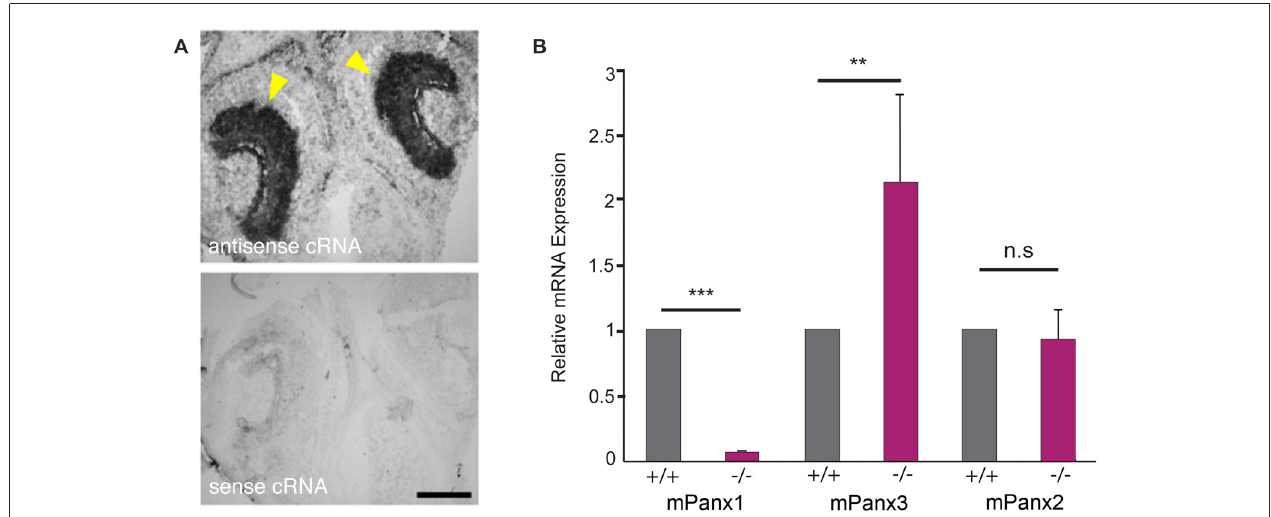
FIGURE 1 | Pannexin mRNA expression in the mouse VNO. (A) In situ hybridizations (ISHs) from juvenile mice (P7) with mPanx1 riboprobes. Panx1 antisense cRNA delivered strong labeling in the VNO. The strongest staining was detectable in the basal cell layer of the sensory epithelium (SE) indicated by yellow arrowheads. Note the absence of specific staining when the Panx1 sense cRNA was used. VNO = vomeronasal organ. Scale bar = 100 µ m. (B) Quantitative room temperature (RT)-PCR data for Panx expression in the VNO. Panx1 − / − mice lacked detectable mPanx1 expression in the VNO ( n = 6). Mouse Panx3 mRNA expression showed a significant 2-fold upregulation in the VNO of Panx1 − / − mice. No differential mRNA regulation was found for mPanx2. Primers specific for 18S rRNA were used as a reference. Experiments were performed in triplicates; significance is denoted by asterisks: Student’s T -test ∗∗∗ p < 0.001, ∗∗ p < 0.01, Error Bars denote SEM.